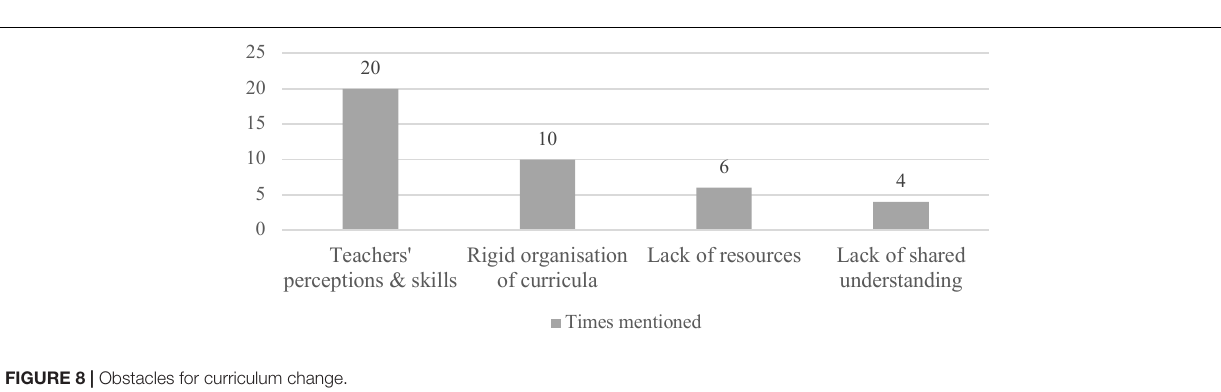
FIGURE 7 | Policymakers’ views on European Commission’s recommendations. Adapted from European Commission (2015).